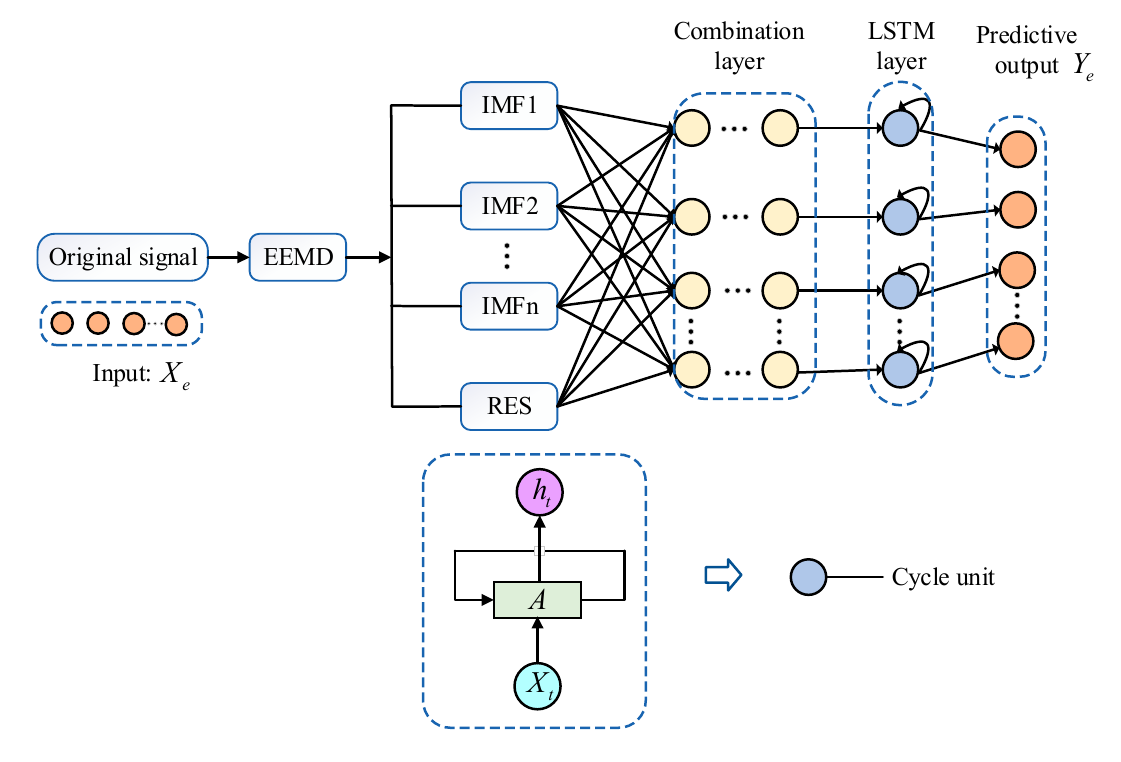
Figure 3. Structure of the EEMD-LSTM.